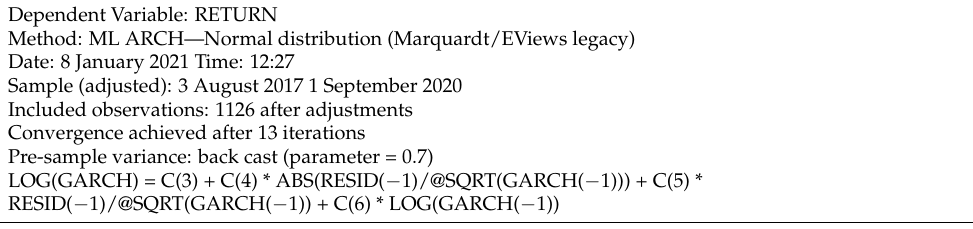
Table 5. Estimated Result of E-GARCH Model for Australian Dollars Return Index during (2017–2020).